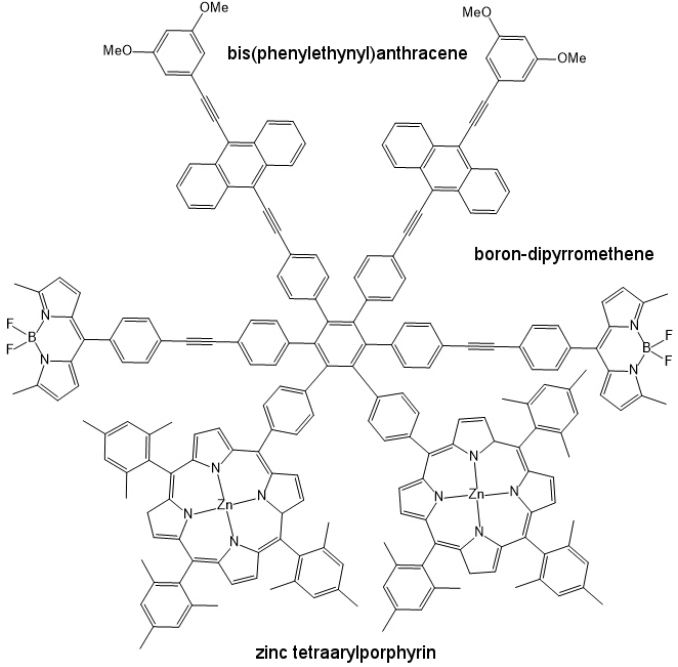
Figure 11. The molecular structure of an artificial antenna model, showing its constituent light absorbing molecules bis(phenylethynyl) anthracene (BPEA), boron-dipyrromethene (BDPY) and zinc tetraarylporphyrin